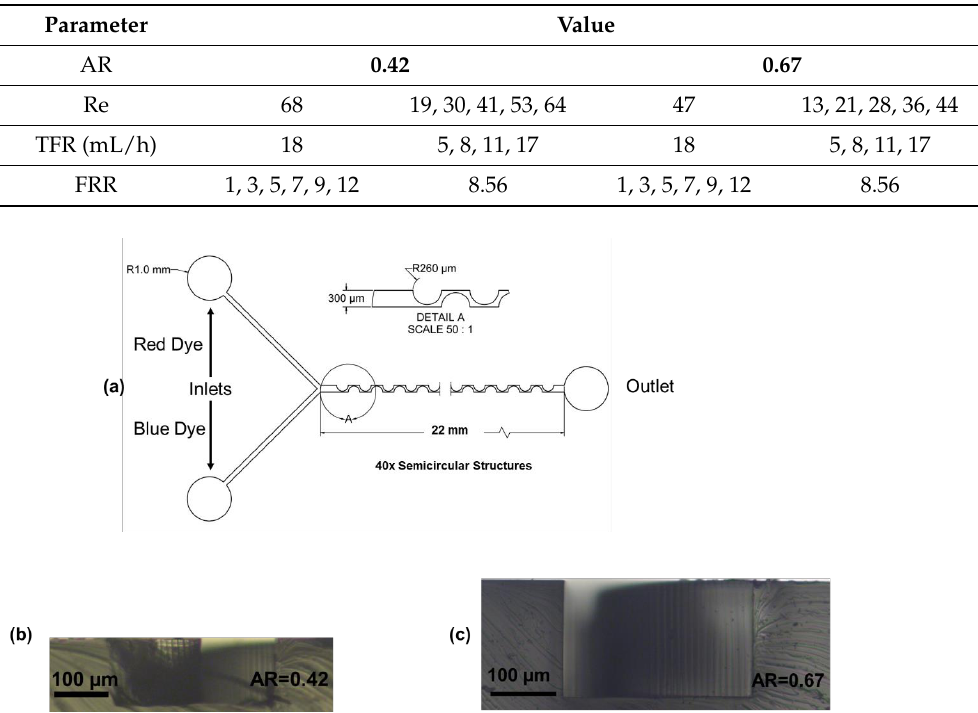
Table 2. Experiment data: The flow-through microfluidic channels.